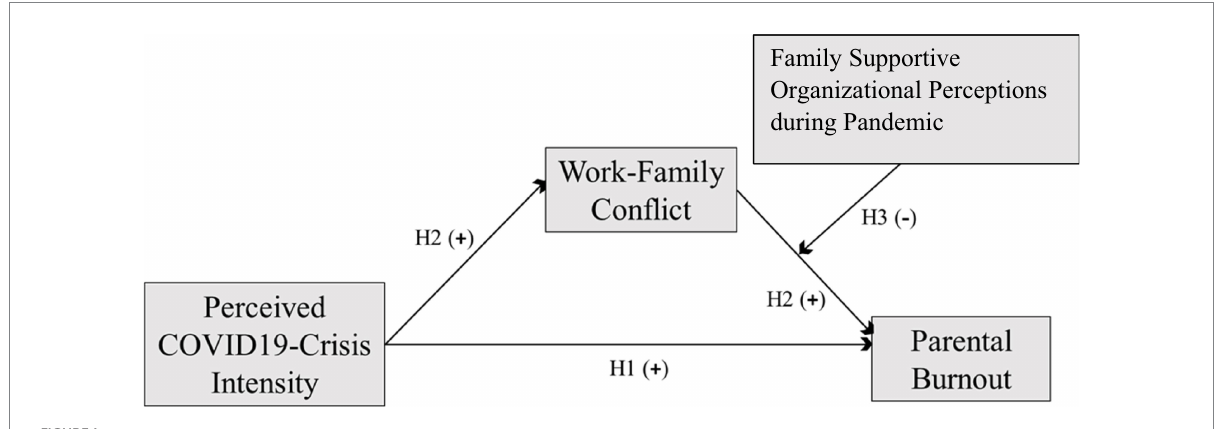
FIGURE 1 Hypothesized Relationships among